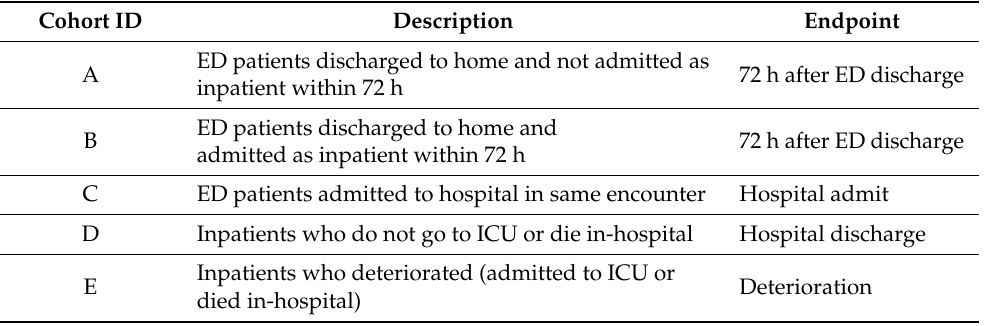
Table 1. Description of cohorts.